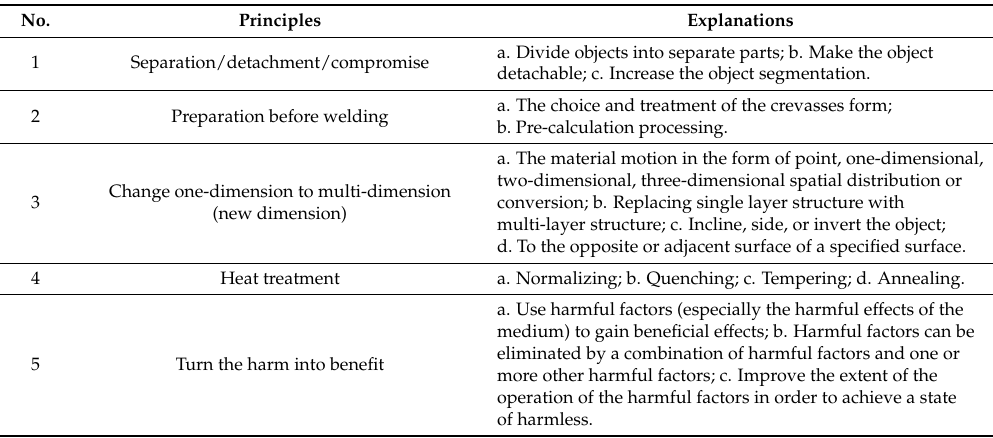
Table A2. Contradiction solving principles of welding process.